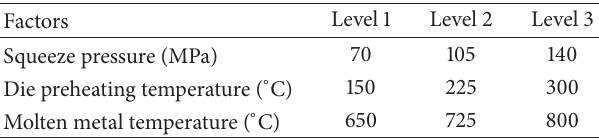
Table 3: Factors and their levels adopted for the 3 3 (L27) full fac- torial design used.